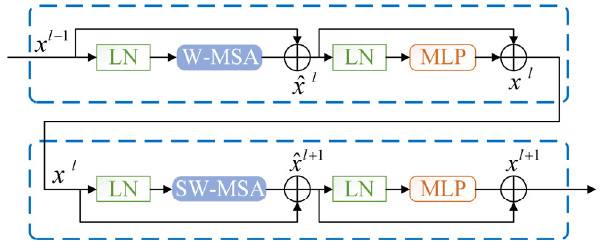
Figure 4. Swin Transformer block.